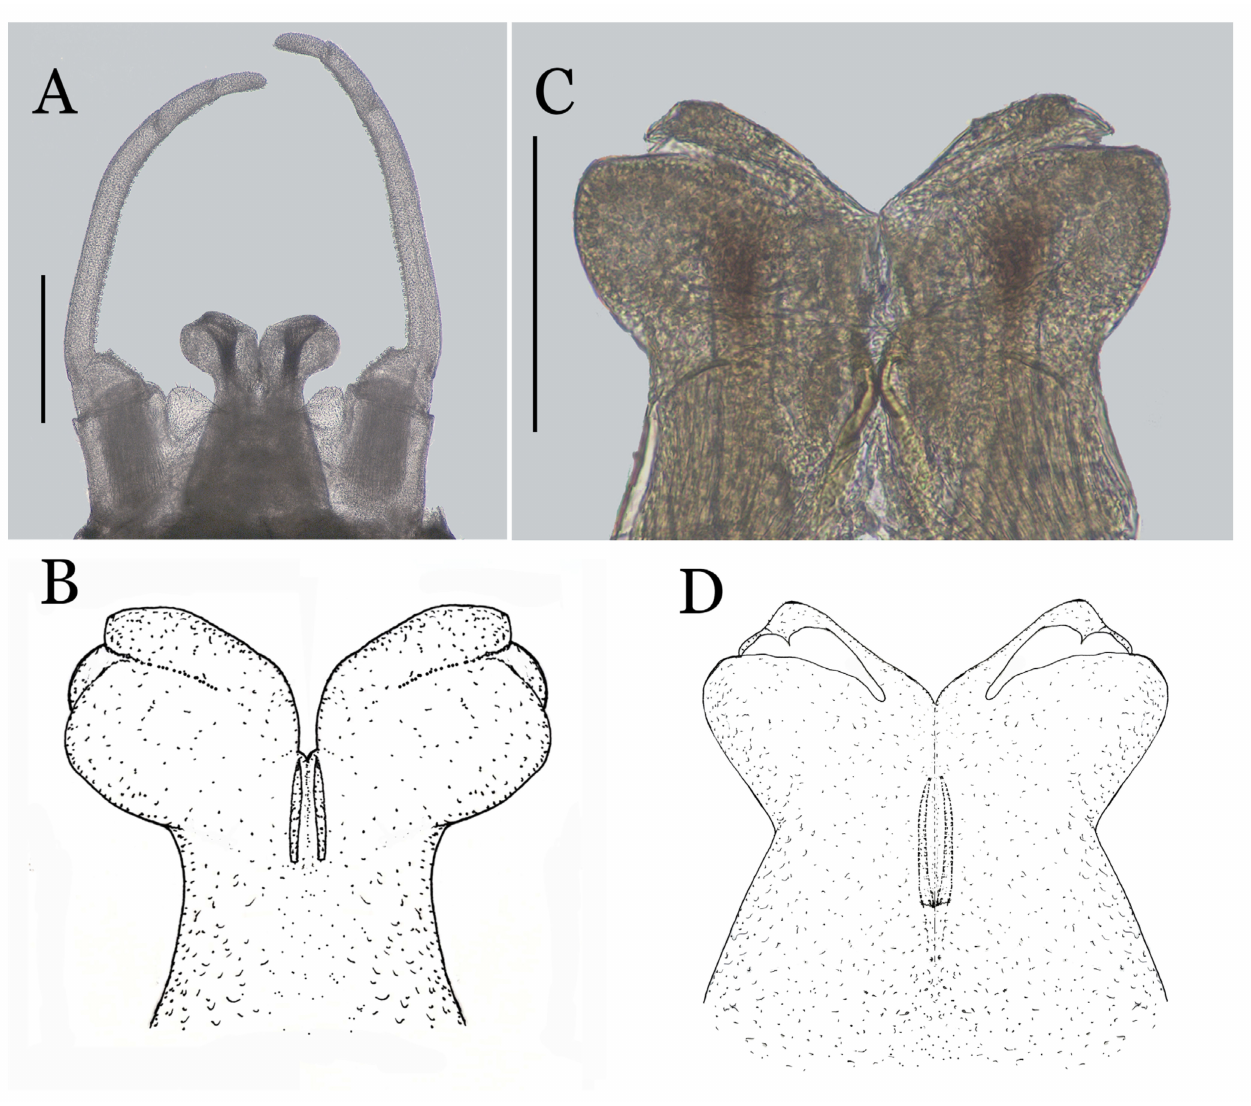
Figure 8. Genitalia of male imago: ( A ) Genitalia (ventral view); ( B ) penes (ventral view); ( C ) penes enlarged (dorsal view); ( D ) penes (dorsal view). Scale bars: ( A ) = 1.0 mm; ( C ) = 0.4 mm. Egg: whole surface covered with KCTs (Figure